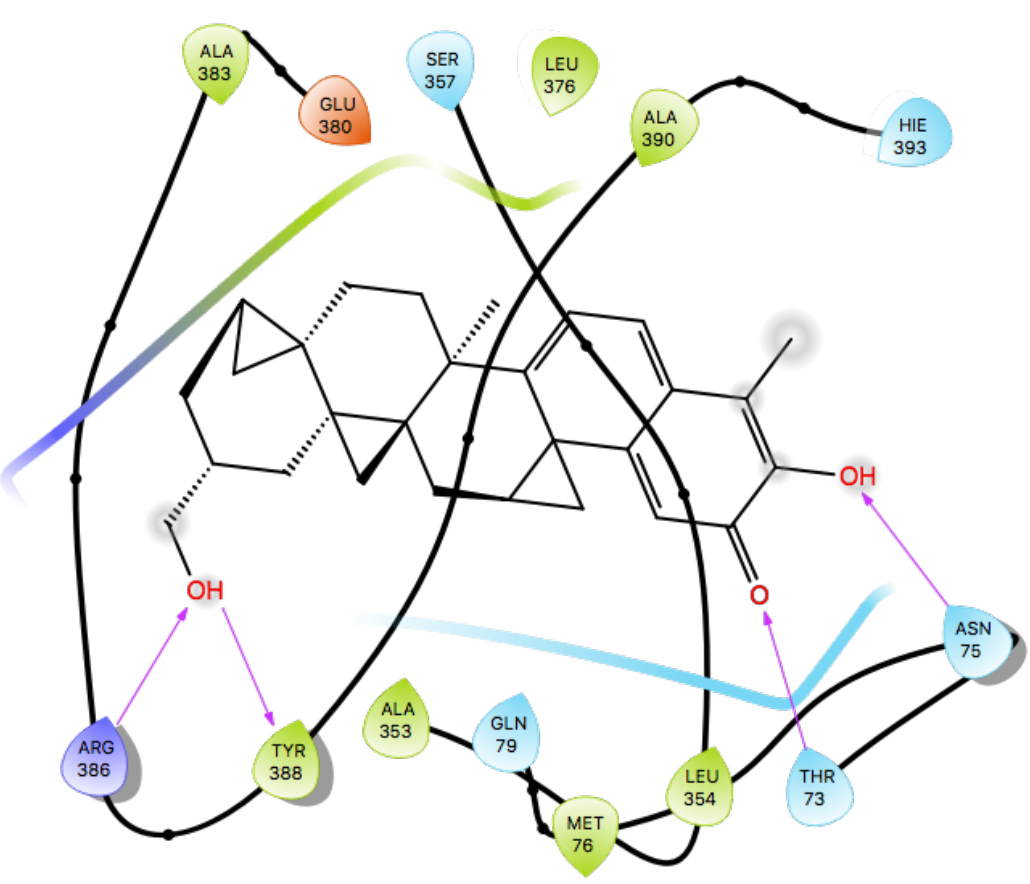
Figure 11. Two-dimensional (2D) representation of molecular interactions of ZINC95485880 ligand complex. Purple arrows represent the hydrogen bonds.